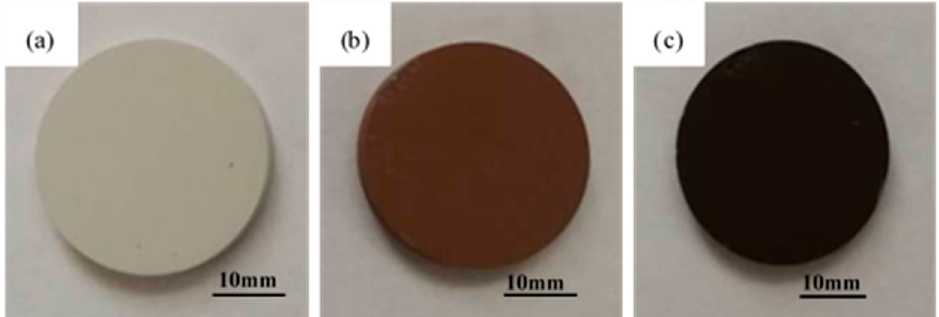
Figure 1. Macrograph of three MAO coatings on AZ91D magnesium alloy, ( a ) MAO, ( b ) MAO–